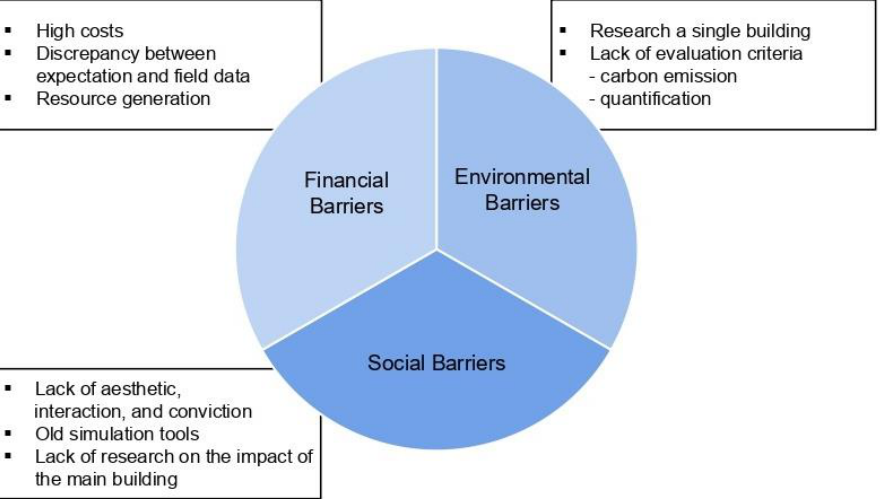
Figure 5. Barriers of AFs popularity.